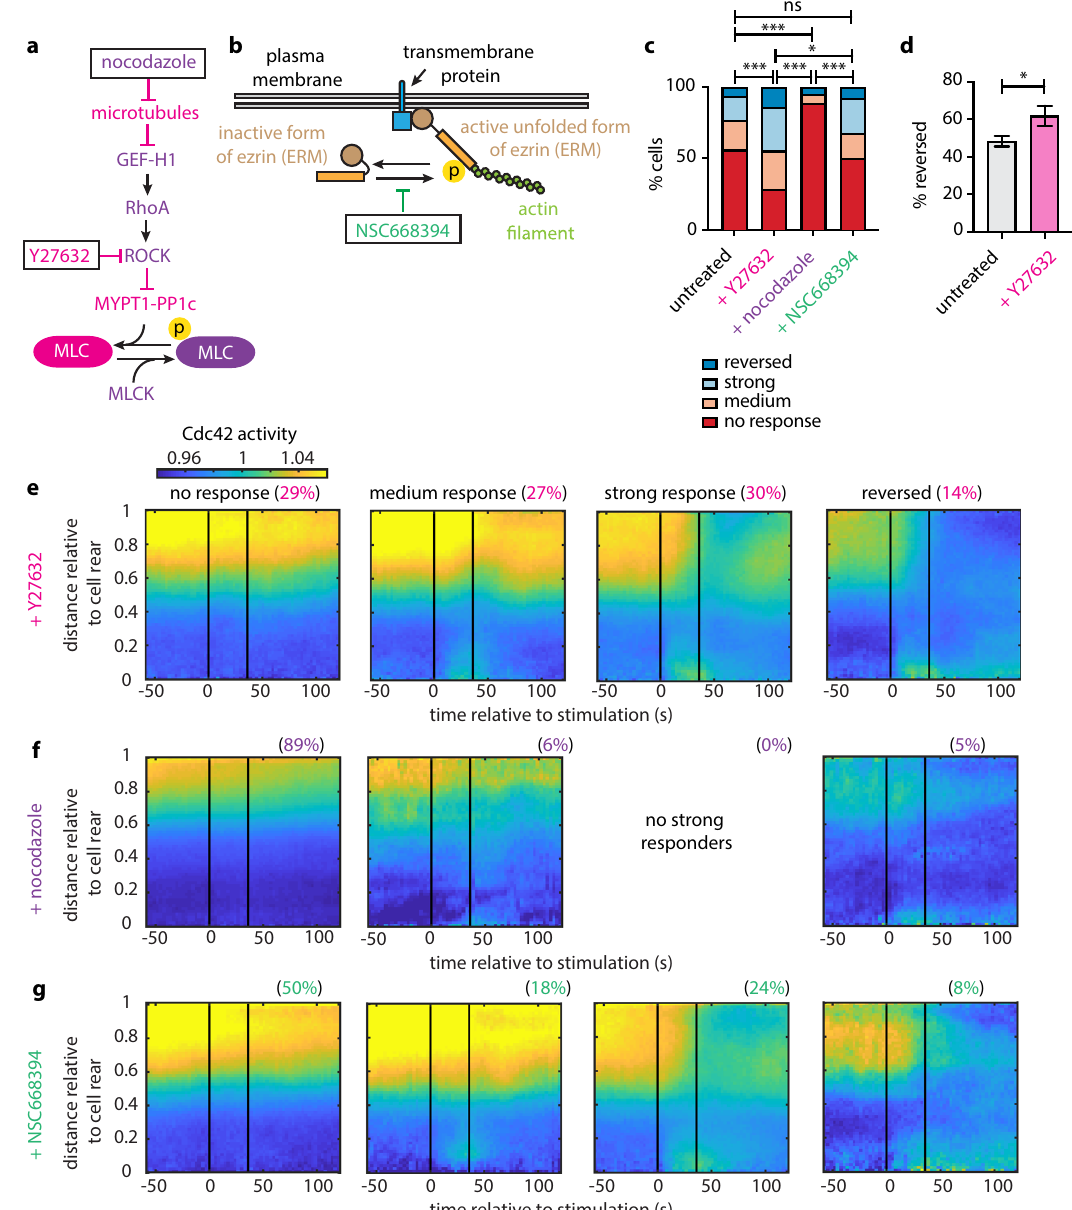
Fig. 5 Perturbations that affect the phosphorylation of myosin regulatory light chain tune the amenability of the rear to respond to receptor inputs. a Diagram of the signaling cascade regulating MRLC phosphorylation. A protein or perturbation that increases or decreases MRLC phosphorylation is colored with purple or magenta, respectively. b Sketch showing how the ERM proteins establish crosslinks between the plasma membrane and cortical actin. c Stacked bar plots of the percentage of cells exposed to transient stimulation that showed no response, medium response, strong response, and reversed for n = 261 untreated cells, for n = 115 Y27632-treated cells, n = 99 nocodazole-treated cells, and n = 91 NSC668394-treated cells (from 20, 7, 7, and 6 independent experiments, respectively); p -values of two-sided Fisher ’ s exact tests (* p < 0.05, *** p < 0.001, ns: p > 0.05). d Bar plot of the percentage of Cdc42-expressing cells that reversed in response to persistent stimulation for n = 336 untreated cells and n = 84 Y27632-treated cells (from 36 and 6 independent experiments, respectively). Error bars represent con fi dence intervals assuming a binomial distribution around the cumulative mean of each group. Two-sided Fisher ’ s exact test revealed a signi fi cant difference between the two conditions (* p < 0.05). e – g Average kymograph representation of Cdc42 activity as a function of time ( x -axis) and vertical position relative to the cell rear ( y -axis) for n = 107 Y27632-treated cells ( e ), n = 76 nocodazole- treated cells ( f ), and n = 84 NSC668394-treated cells ( g ). Vertical black lines indicate the start and end of the pulsated stimulation. Source data are provided as a Source Data fi le, including the exact p